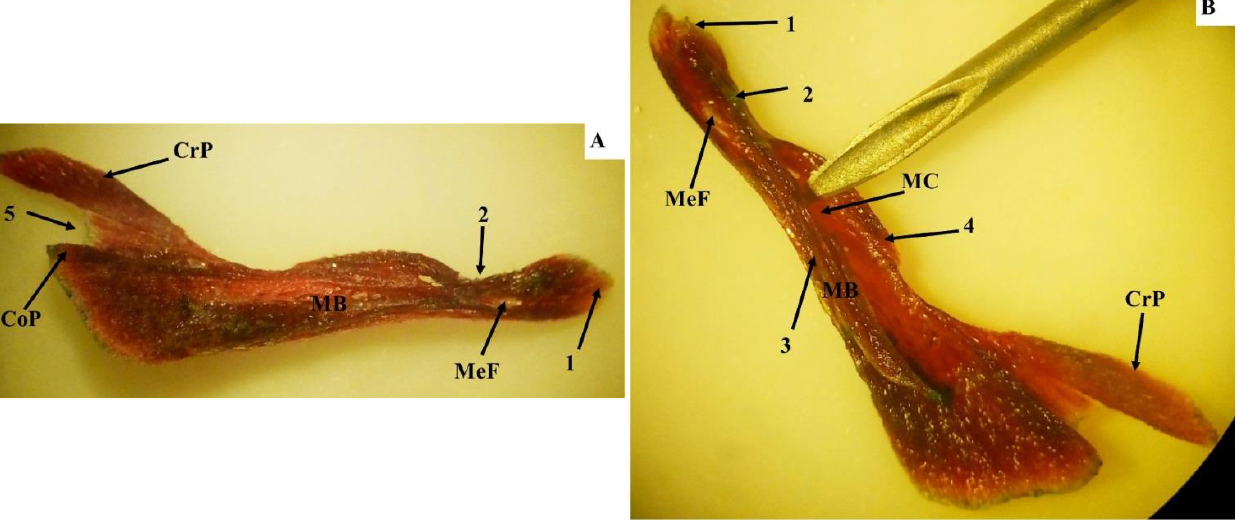
Figure 5. A stereomicrograph of the lateral (A) and dorsomedial view (B) of a 67 th day old Balami fetal mandible, showing the mandibular body (MB) mandibular rami (MR) mental foramina (MeF) and opened mandibular canal (MC), coronoid processes (CrP), alveolus for incisors teeth (1), mandibular incisure (2), medial part of MB (3) and lateral part of MB (4), and intercondylar notch (5), Alizarin stain